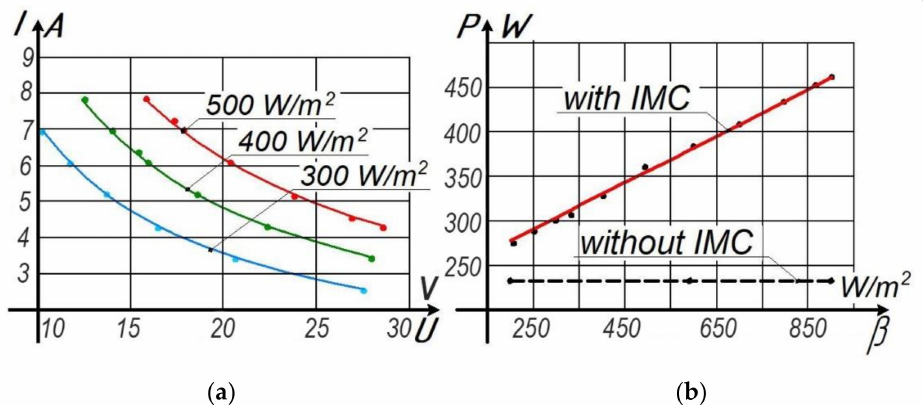
Figure 7. Results of modeling the operation of a solar cell array with individual matching converters, ( a )—volt-ampere characteristics of the matching converter at different values of the radiation intensity; ( b )—dependence of the array output power on the radiation intensity of one of the modules (dots show the results of experimental